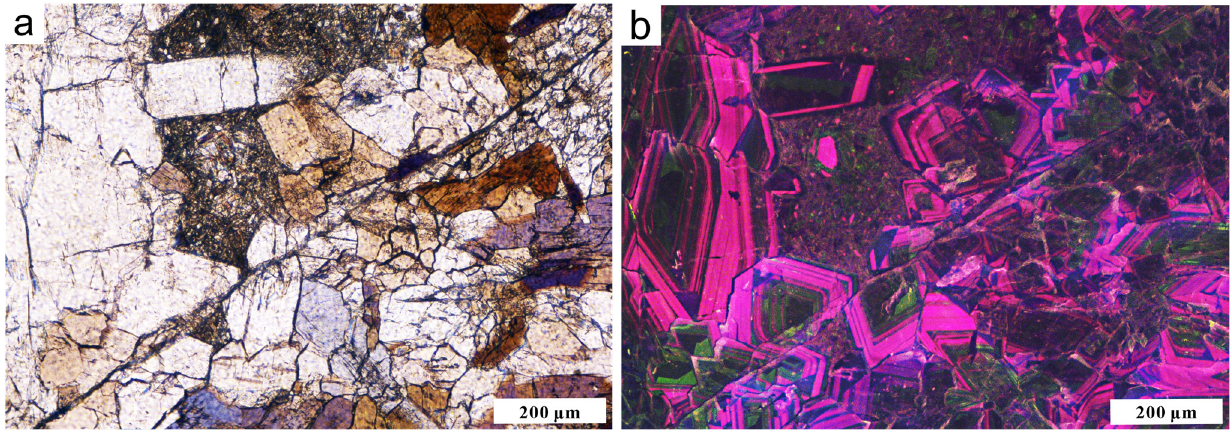
Figure 4. The jadeite grains display euhedral to subhedral prismatic crystal habits (under cross- polarized light).